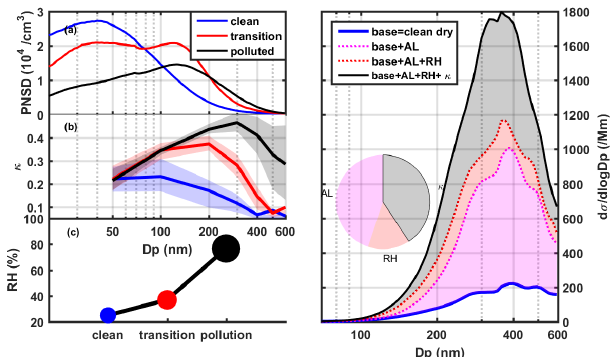
Figure 8. Panel (a) is the mean PNSD under different pollution con- ditions. Panel (b) is the mean size-resolved κ under different pollu- tion conditions. Panel (c) is the mean RH under different conditions. Panel (d) shows the effects of different factors (aerosol loading, RH, and κ variation) on the size-resolved light extinction. The areas of different colors are shown in the pie chart on the